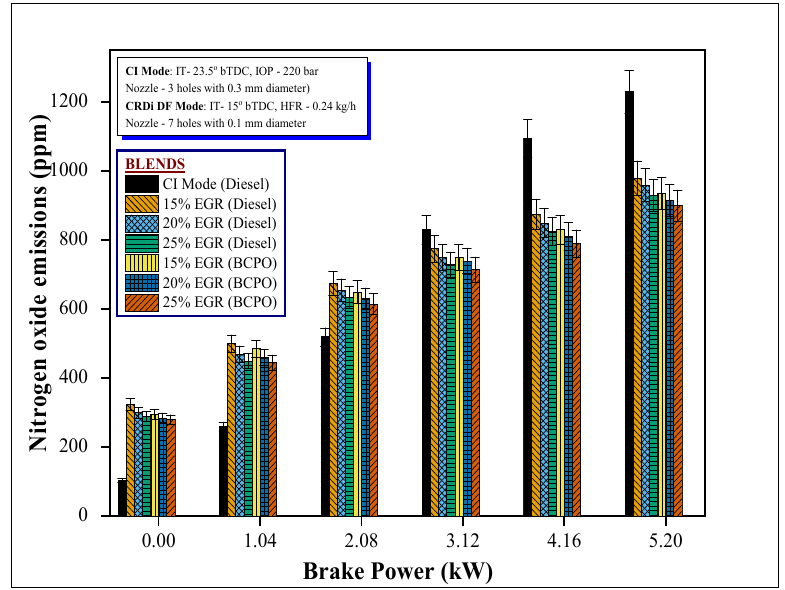
Figure 16. EGR and BP influence on CRDi engine NOx emissions.